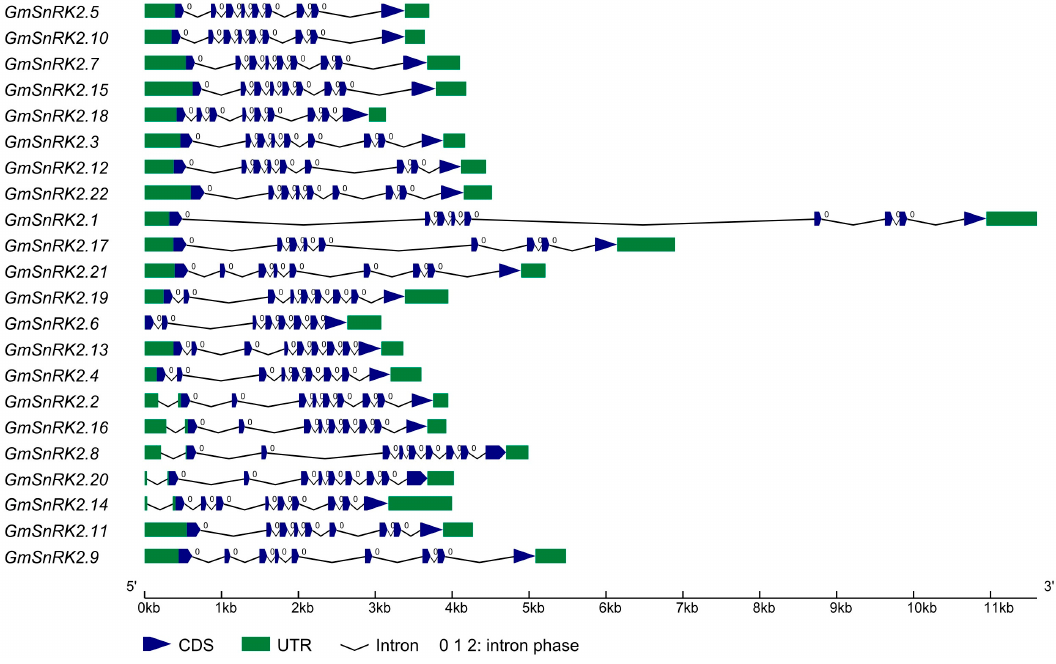
Figure 1. Gene structure of GmSnRK2 genes. Introns are represented by black lines. Exons are represented by blue wedges. 5 ′ and 3 ′ untranslated regions (UTRs) are represented by green boxes. The intron phase is labeled above each intron. The scale of gene length is given at the bottom. CDS: Coding sequence.